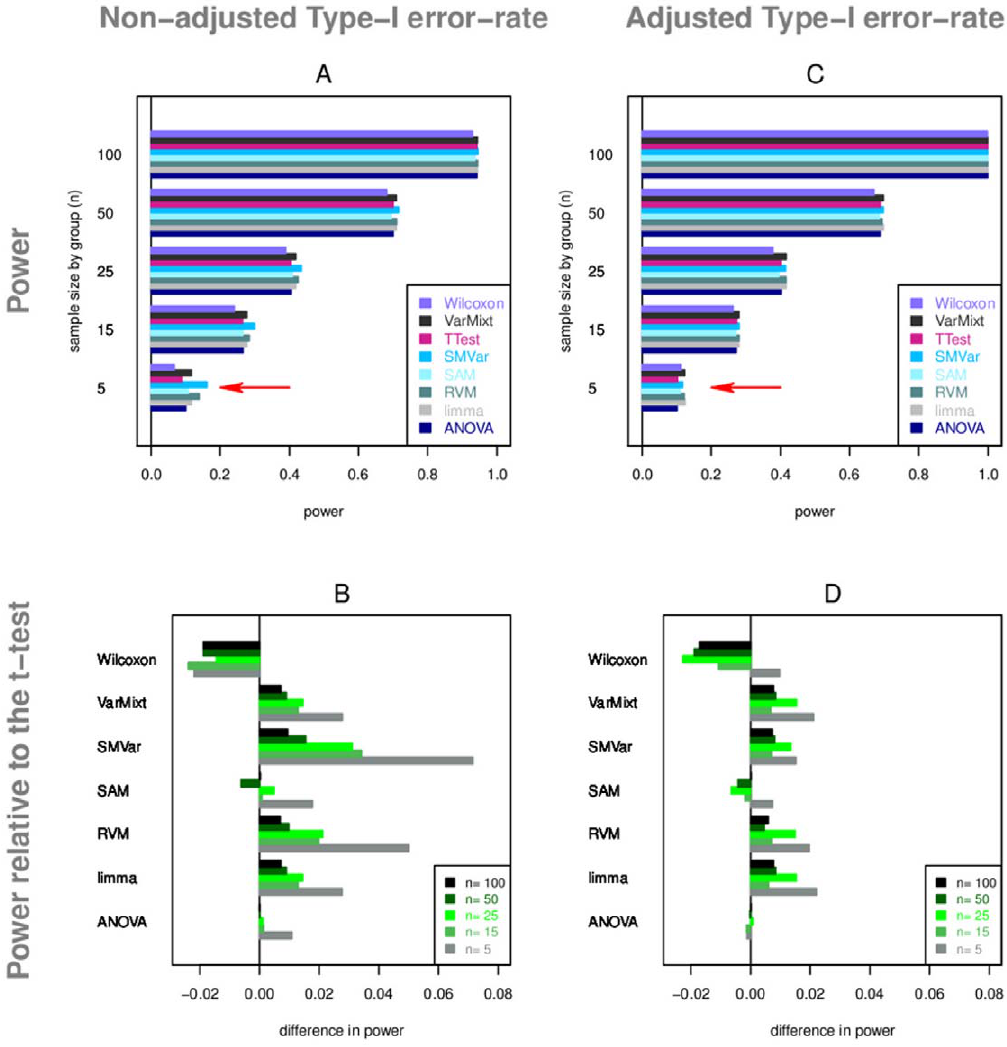
Figure 3. Power study from simulations (Gaussian model, M1). Power values are calculated at the 5% level and displayed according to the sample size. Figures A and C represent power values. Red arrows highlight the effect of false-positive rate adjustment on power values. Figures B and D represent power values relative to t-test. Figures A and B concern power values calculated at the actual false-positive rate. Figures C and D concern power values calculated at the adjusted false-positive rate.